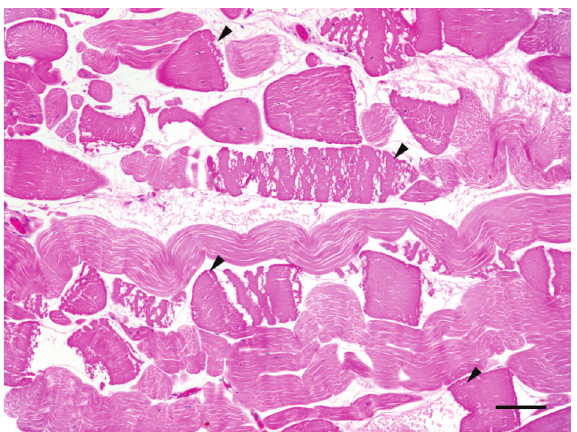
Figure 2: Pectoral muscle of a green turtle ( Chelonia mydas ) inci- dentally captured in a large mesh gillnet. There is multifocal necrosis of individual myofibers that is characterized by hypercontraction, loss of cross striations, and segmental disruption of the sarcoplasm (black arrowheads). Hematoxylin and eosin. Scale = 100 𝜇